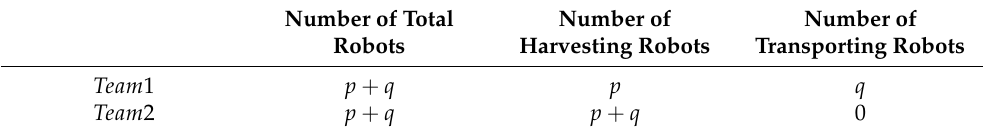
Table 1. Setup of comparison groups to compare